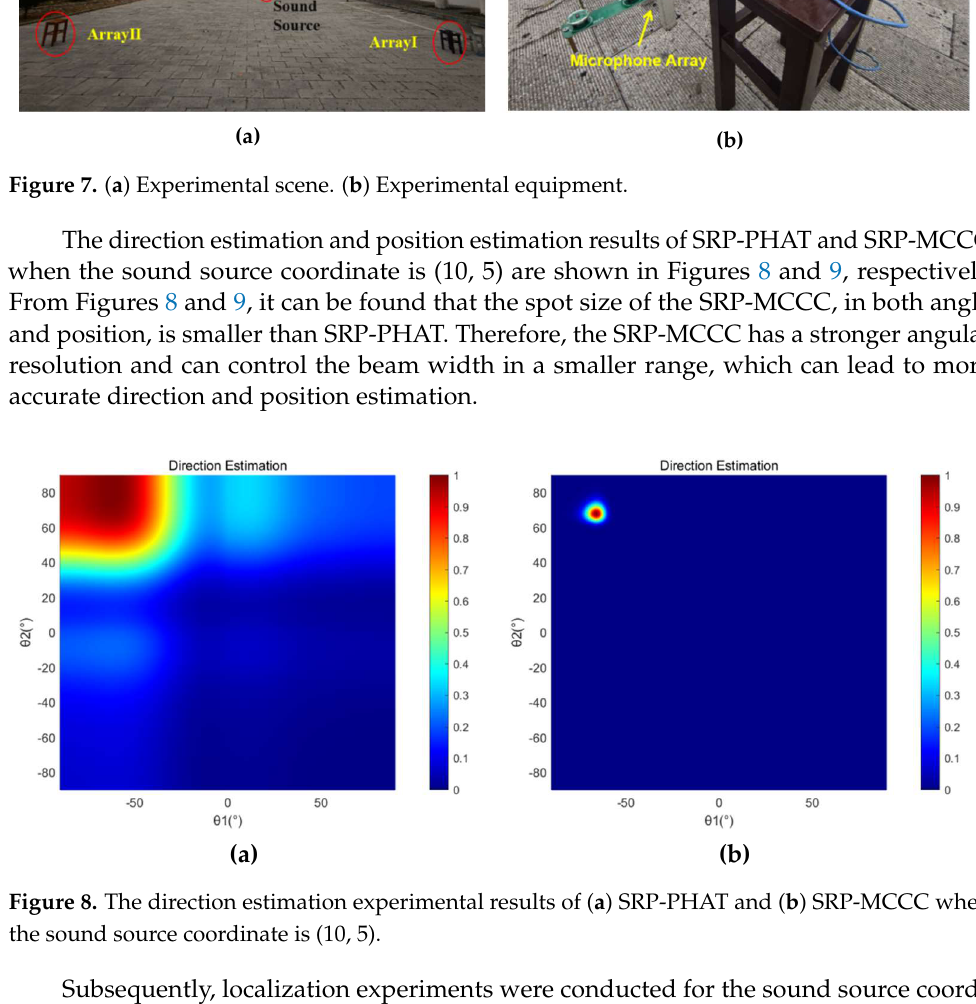
Figure 9. The location estimation experimental results of (a) SRP-PHAT and (b) SRP-MCCC when the sound source coordinate is (10, 5).